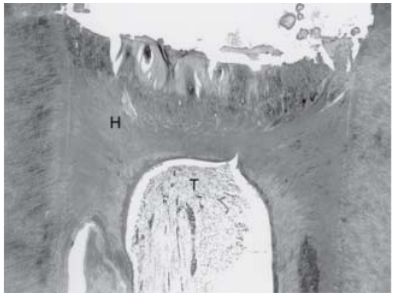
FIGURE 6- Group II (Calcium hydroxide): dentin bridge obliterating the pulp exposure (H). Normal connective pulp tissue (T). (hematoxylin and eosin - X